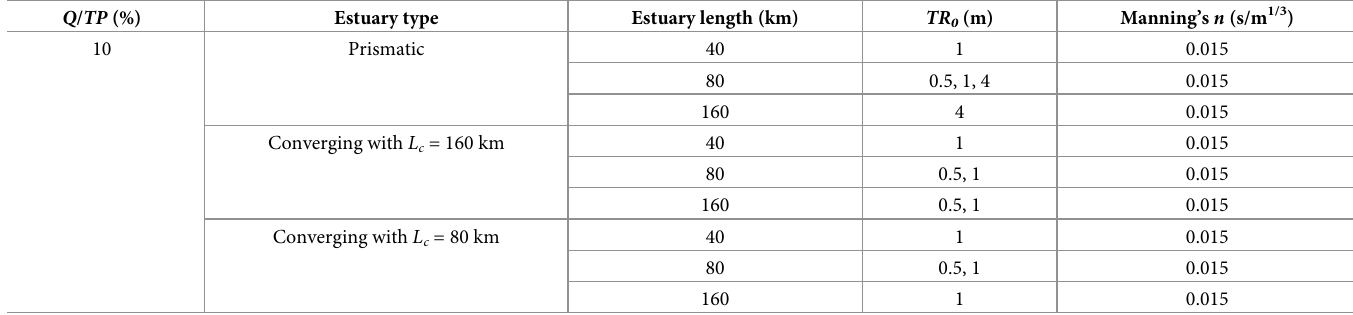
S1 Table. A summary of estuarine tidal range responses to SLR during no river discharge conditions ( Q / TP = 0%) for prismatic estuaries. S2 Table. A summary of estuarine tidal range responses to SLR during low river discharge conditions (Q/TP = 1%) for prismatic estuaries. S3 Table. A summary of estuarine tidal range responses to SLR during medium river dis- charge conditions (Q/TP = 5%) for prismatic estuaries. S4 Table. A summary of estuarine tidal range responses to SLR during high river discharge conditions (Q/TP = 10%) for prismatic estuaries. S5 Table. A summary of estuarine tidal range responses to SLR during no river discharge